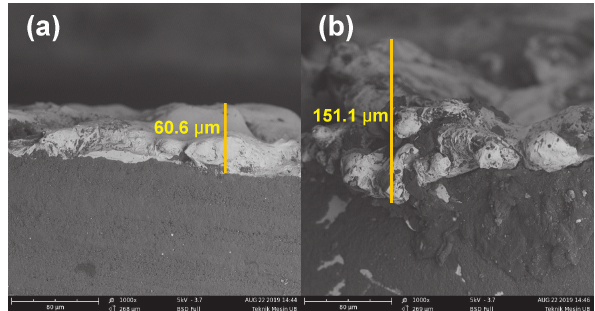
Figure 5: SEM images of side view on BMG machined surface at (a) 4 A, 50 µ s combination and (a) 12 A, 150 µ s combination using 1000 times magnification performing recast